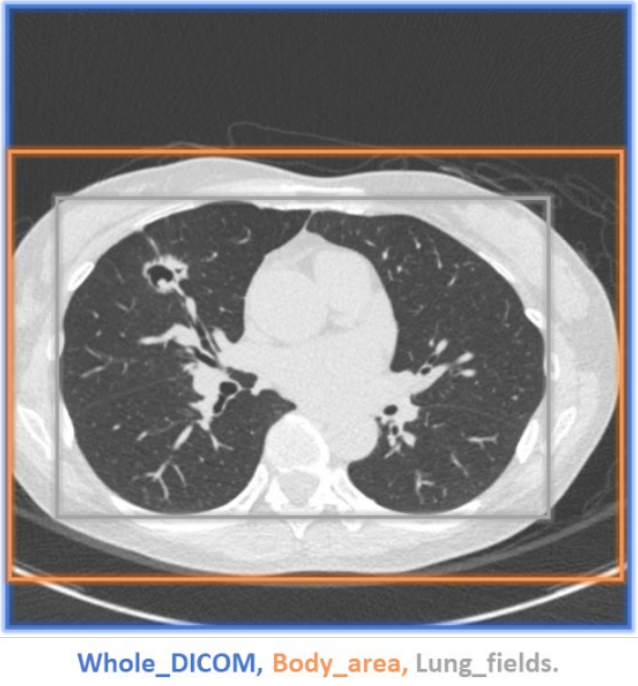
Figure 11. Demonstration of ROI selection. Blue box: whole DICOM image; Orange box: body area; Gray box: lung fields. Table 7. Mean image quality metrics of different ROIs in SR images compared to the ground-truth HR images. ( a ) Mean PSNR of different ROIs in SR models. ( b ) Mean SSIM of different ROIs in SR models.